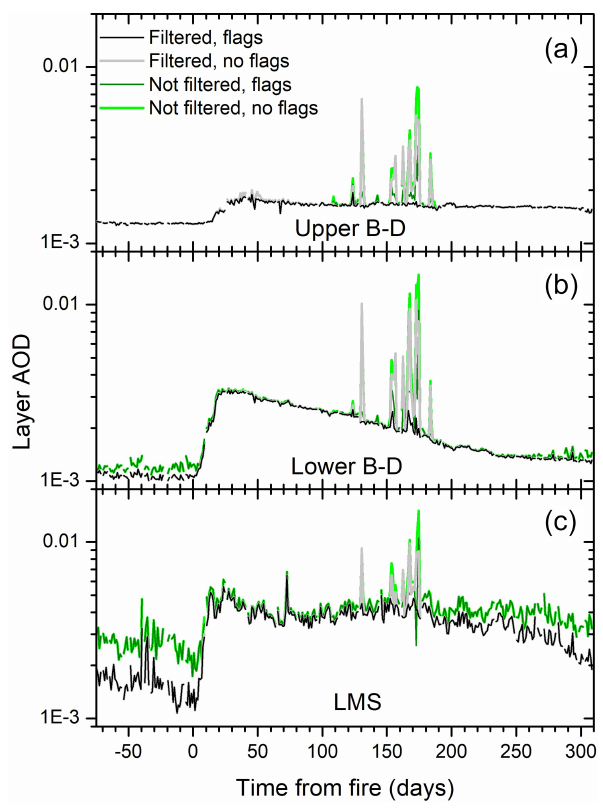
Figure 4. OMPS-LP layer AODs averaged over 20 to 80 ◦ N for the 745nm wavelength using data filtered and not filtered from clouds and polar stratospheric clouds, as well as with and without data flagged for data quality. Layer AOD for (a) the upper Brewer– Dobson branch (470K isentrope – 35km), (b) the lower Brewer– Dobson branch (380–470K), and (c) the LMS (tropopause – 380K) are